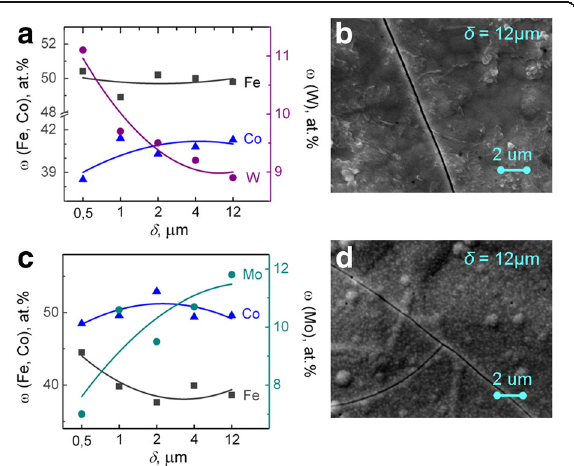
Fig. 5 The distribution of alloying elements over the thickness of the coating and SEM images of coatings deposited in galvanostatic mode. a , b Fe-Co-W. c , d